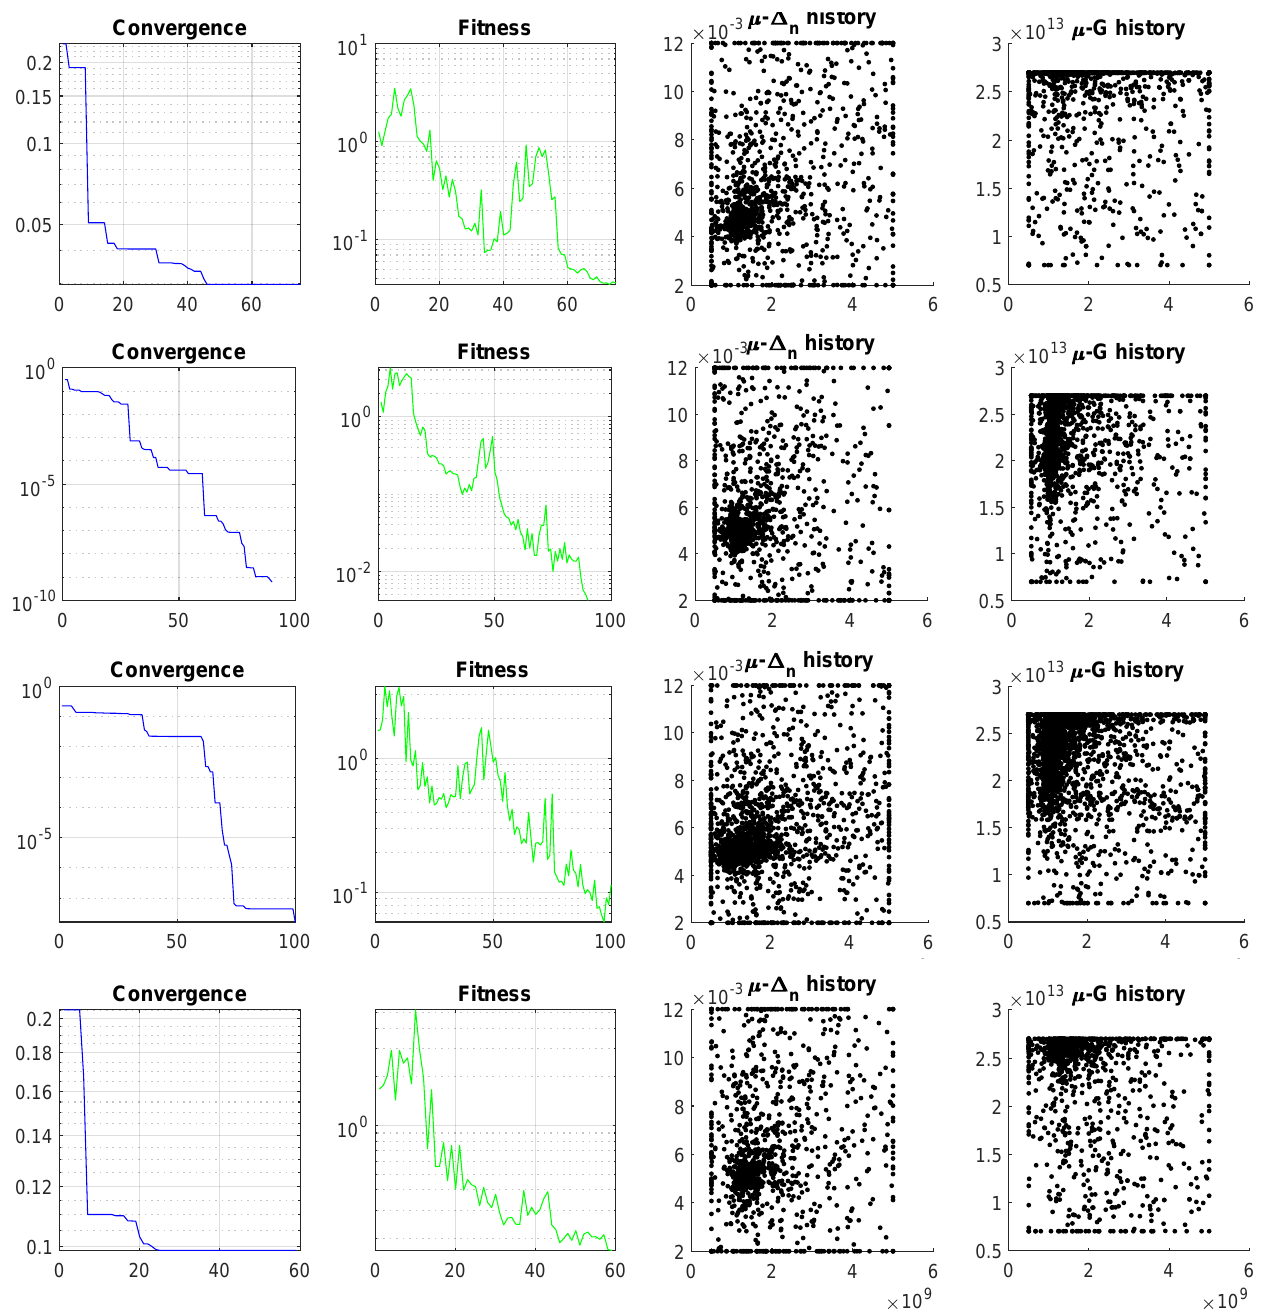
Figure A2. Blue plot is the convergence of the PSO algorithm (minimum value of f ( x )) , green plot is the fitness of the population (mean value of f ( x )) , both plots horizontal axes are the PSO iterations. The two scatter plots represent different planes in the optimization variable space, µ − ∆ n and µ − G . The axes are in the units of the corresponding variable, Pa or adimentional for ∆ n . Swarm Population: 40. Objective function f ( x ) resolution from top to bottom: 8–16–32–64